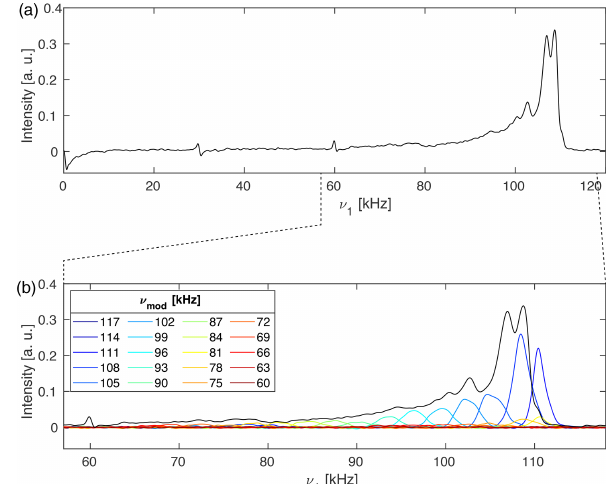
Figure 5. (a) 1 H nutation spectra of natural-abundance glycine measured at a proton-resonance frequency of 500MHz spinning at 30kHz in a Bruker 1.9mm outer-diameter rotor which was com- pletely filled. The nutation spectrum without selective inversion (black) shows MAS modulation bands at 30 and 60kHz due to the MAS-induced time dependence of amplitude and phase of the rf irradiation. (b) Expanded region of (a) overlaid in colour with var- ious difference spectra using a 2ms I-BURP-2 pulse in the spin- lock frame where the modulation frequency was moved through the width of the nutation spectrum. Contributions that lie outside the nutation spectrum are due to the drift of the radio-frequency ampli- fier gain over the course of different experiments. To allow a more detailed view of the various sub-spectra in (b) , they are also shown in a separated plot in Fig.